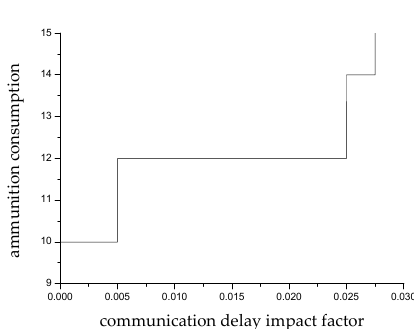
ff erent communication delay influence Figure 7. Weapon consumption under different communication delay influence factors. Figure 7. Weapon consumption under di